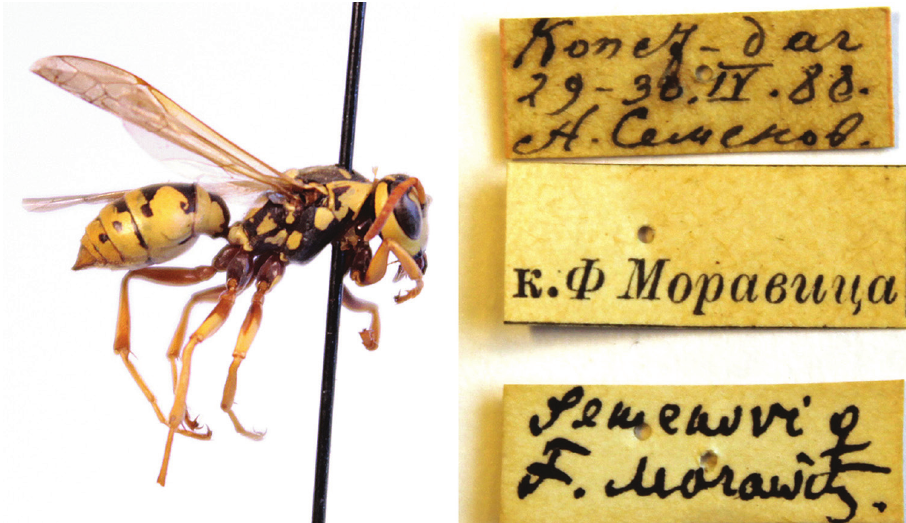
Figure 57. Polistes semenowi . Lectotype female, habitus, lateral aspect, and labels. Photo: K. Samartsev. Pseudopolistes sulcifer var. similator Zirngiebl, 1955, Mitt. Münchner Entomol. Ges. 44/45: 384. Holotype female (ZSM, examined by CvA and CSE), type locality: Ordubad [19]13, leg. Klar. Syn.